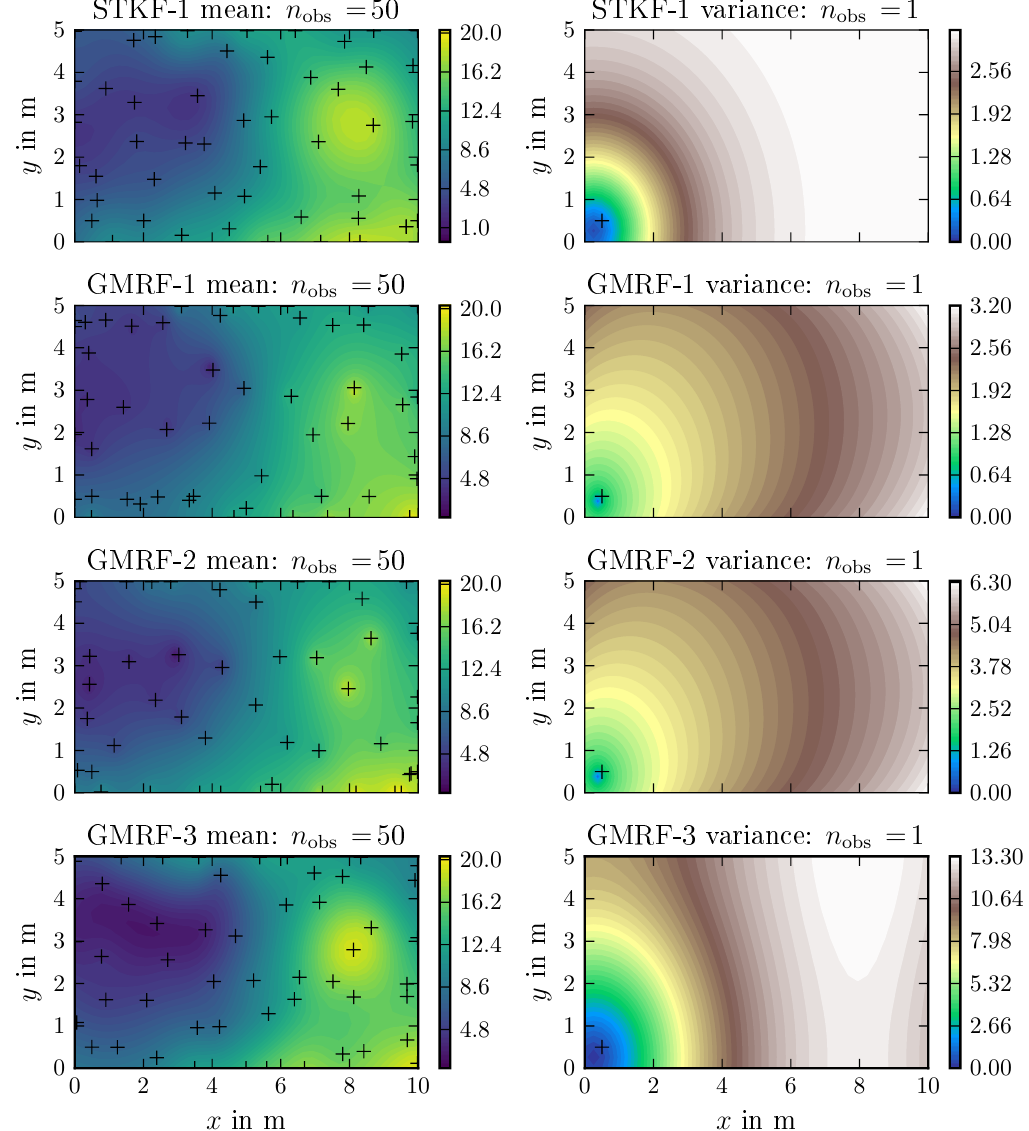
Figure A1. Estimation results of the Gaussian belief models. The parameters of the regression algorithms are denoted in Table 2. Left: Predicted field mean of different regression models after fifty observations. In each prediction step the next observation was chosen to be close to the maximum predicted variance. Right: Predicted field variance of different belief models after one